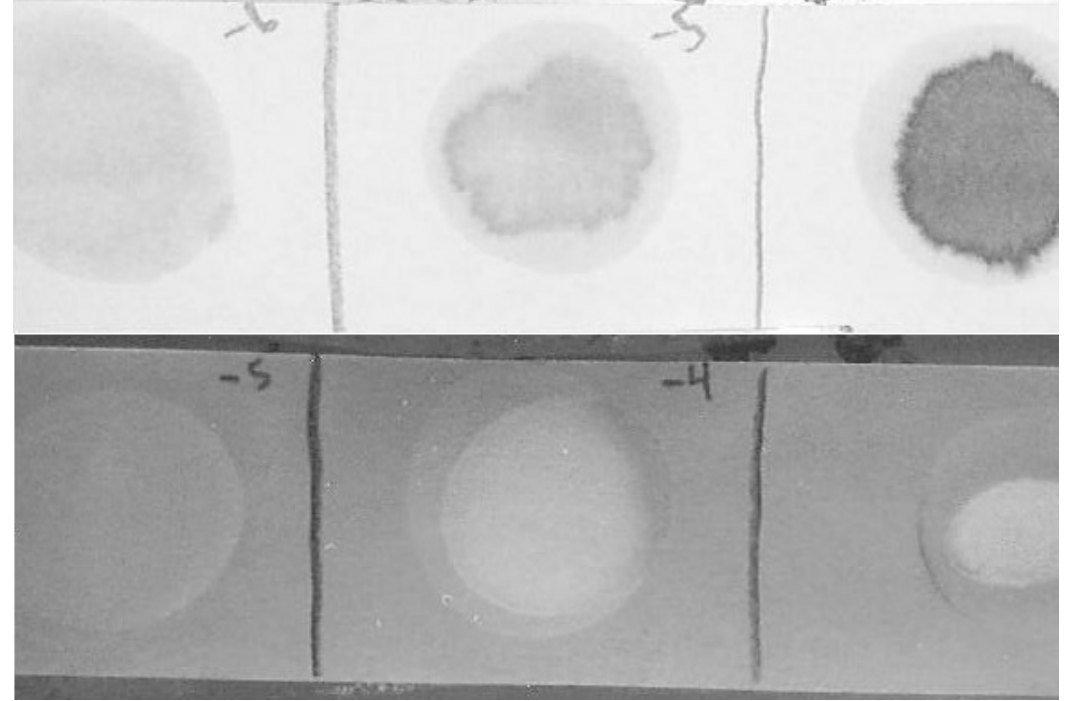
FIGURE 5. Colorimetric ETK Plus (top) and europium/OP photoluminescence (bottom) sensitivity comparison for smokeless powder. See text.